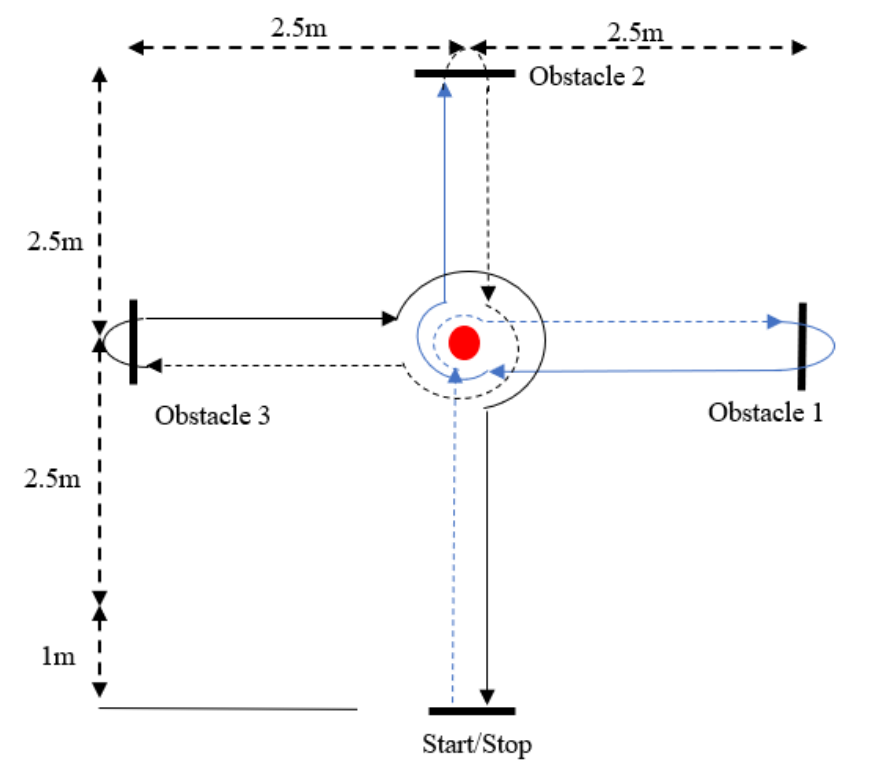
Figure 2. Harre circuit test (HCT).